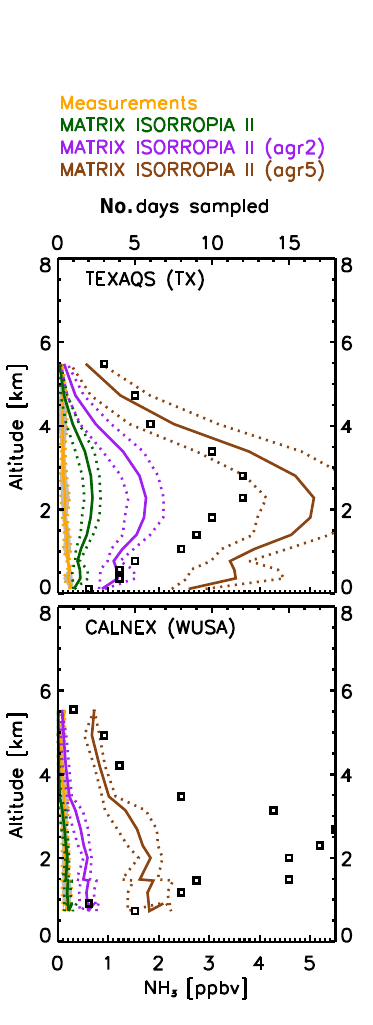
Figure A4. Mean regional NH 3 profiles from the TexAQS (upper panel) and CALNEX (lower panel) campaigns. Measurements are in orange, MATRIX-ISORROPIA II with regular emissions is in green, with double agricultural NH 3 emissions in purple, and with 5 times higher agricultural NH 3 emissions in brown.